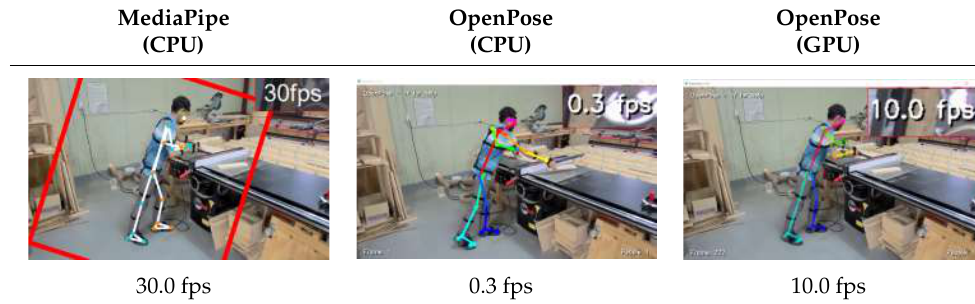
Table 3. The FPS comparison of the posture of a wood manufacturing worker.